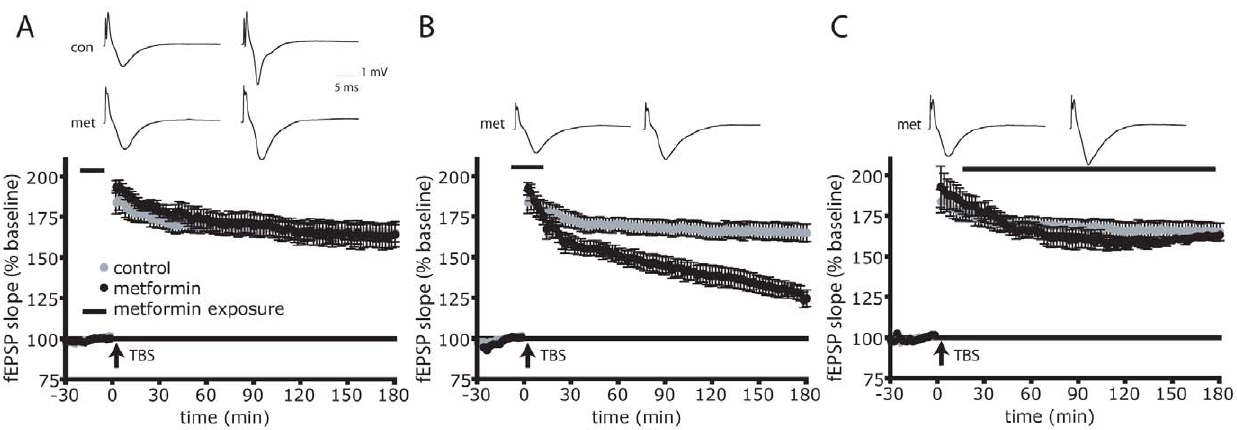
Figure 5. AMPK activation suppresses L-LTP within a time-restricted window. A) 5 m M metformin was added 20 minutes prior to TBS and washed out immediately prior to TBS (n=8). L-LTP at 180 minutes post TBS was equal to control (n=17), B) metformin was added immediately prior to TBS and washed out immediately after TBS (n=8). L-LTP was reduced to 30% of control (p=0.0172). C) metformin was added 5 min after stimulation for the duration of the experiment (n=5). L-LTP at 180 minutes was indistinguishable from control. Control data in Fig. 5A is reproduced in Fig. 5B and Fig. 5C for comparison. Inset: Representative fEPSP traces shown were taken 4 minutes prior to and 180 minutes after TBS. Error bars show s.e.m.